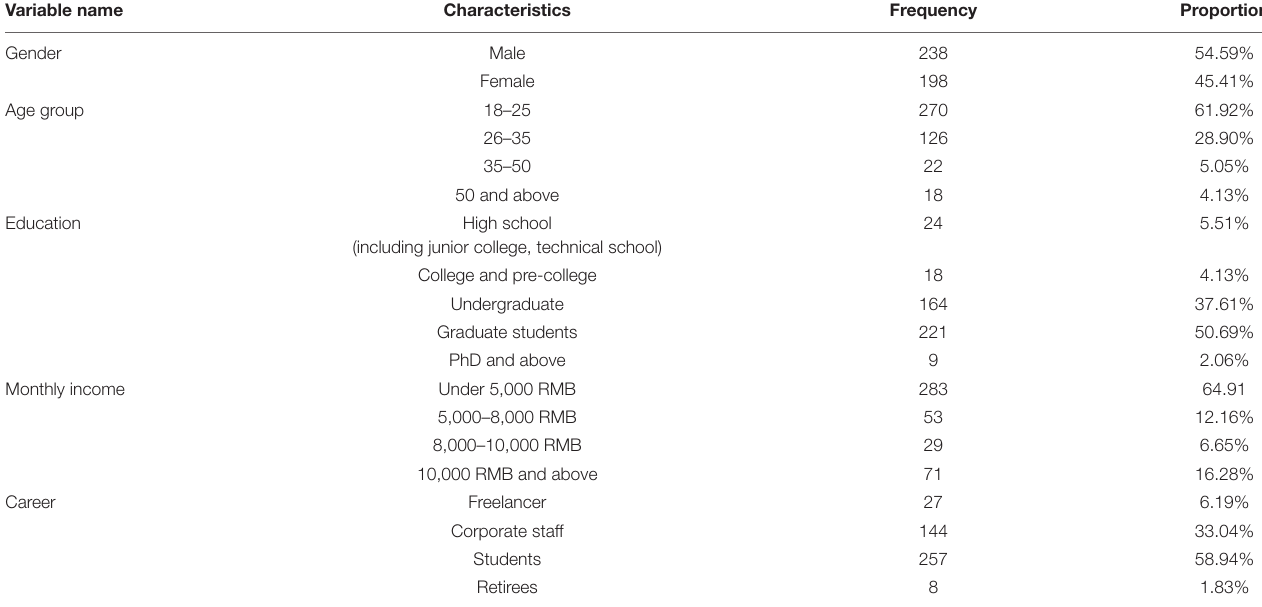
TABLE 3 | Sample descriptive statistics.